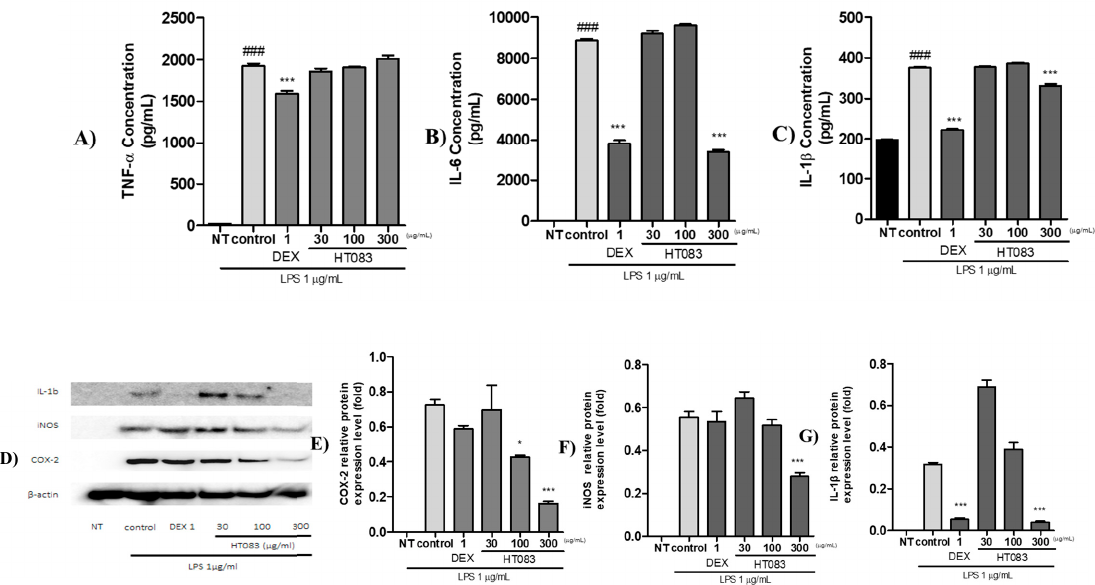
Figure 8. Effects of HT083 on the protein expression of inflammatory cytokines in LPS-stimulated RAW264.7 cells. ( A – C ) Multiplex analysis of the expression of TNF α , IL-6, and IL-1 β . Cells were stimulated with PBS, trophozoite lysates or LPS for 24 h. Supernatants were harvested and inflammatory cytokine concentrations (pg / mL) were measured. * p < 0.05, *** p < 0.001 indicate statistically significant differences from the control group. ### p < 0.001 indicates significant difference from the non-treated (NT) group. ( D – G ) Western blot image and analysis of the expression of COX-2, iNOS and IL-1 β .